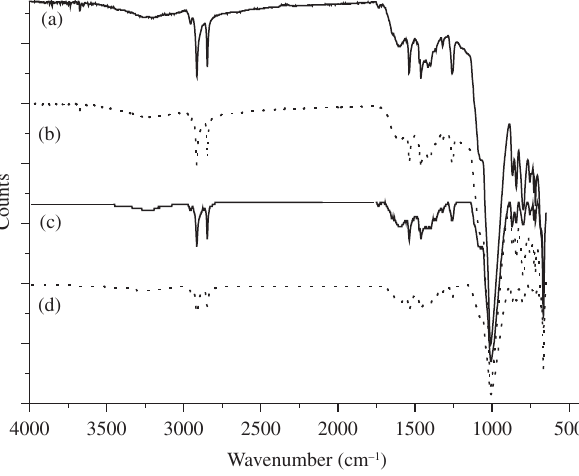
sonicated.160 Figure 3. Si (A) and Ce (B) peaks intensity in EDS spectra of single- or bi-layer coated AA 2024-T3 samples prior and after the adhesion test: curve (A) Al-Si; curve (B) Al-Si – sonicated; curve (C) Al-Ce-Si; curve (D) Al-Ce-Si – sonicated; curve (E) Al-Ce; curve (F) Al-Ce –